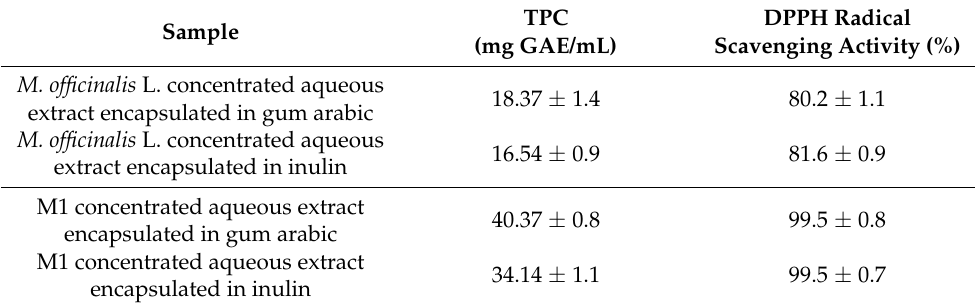
Table 3. TPC and DPPH radical scavenging activity of Melissa officinalis L. and M1 concentrated aqueous extracts encapsulated in gum arabic or